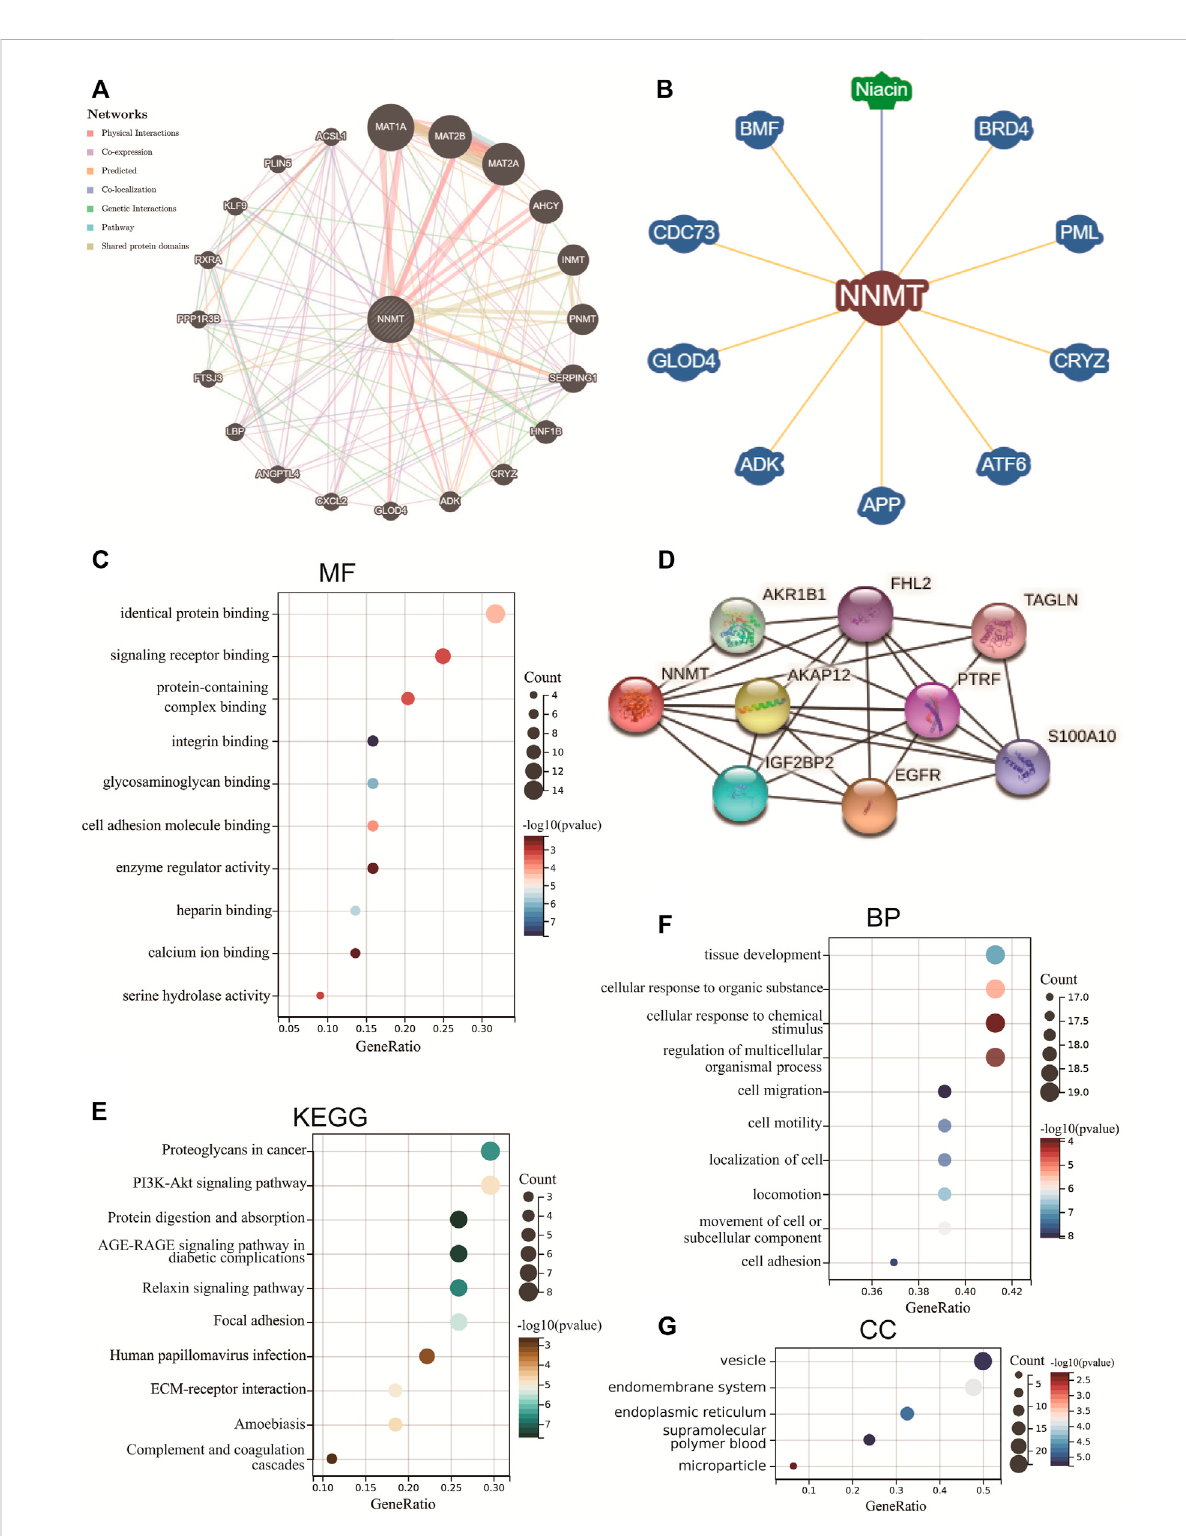
FIGURE 12 NNMT-related protein-protein interact (PPI) networks and gene enrichment analysis. PPI networks for NNMT using the GeneMANIA database (A) , BioGRID database (B) and STRING database (D) . (C) Molecular function (MF), (E) Kyoto Encyclopedia of Genes and Genomes (KEGG), (F) biological process (BP) and (G) cellular components (CC) analysis of the top 50 genes co-expressed with NNMT obtained by the